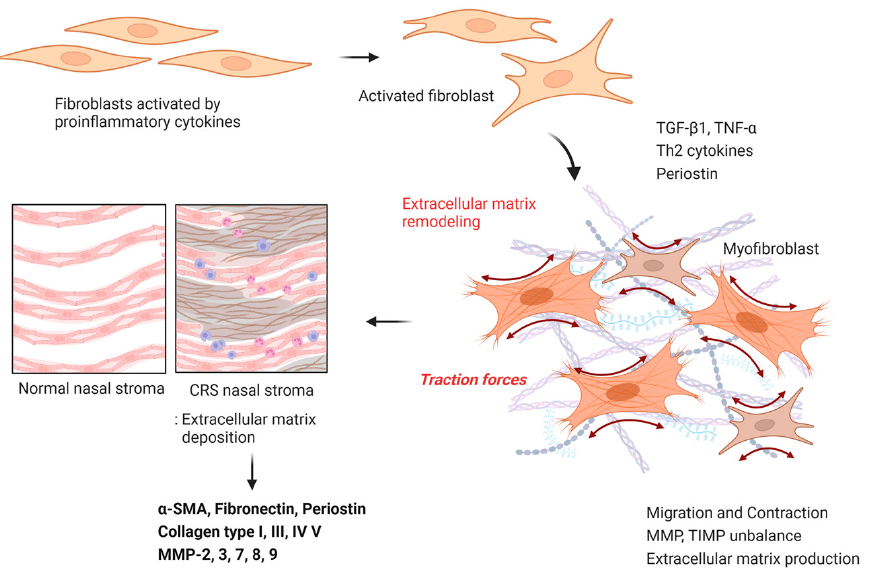
Figure 2. Myofibroblast differentiation and extracellular matrix deposition. Differentiated myofi- broblasts have improved ECM generation, migration, and contraction abilities. The regulation of ECM, MMPs, and TIMPs produced by these cells affects tissue ECM accumulation.